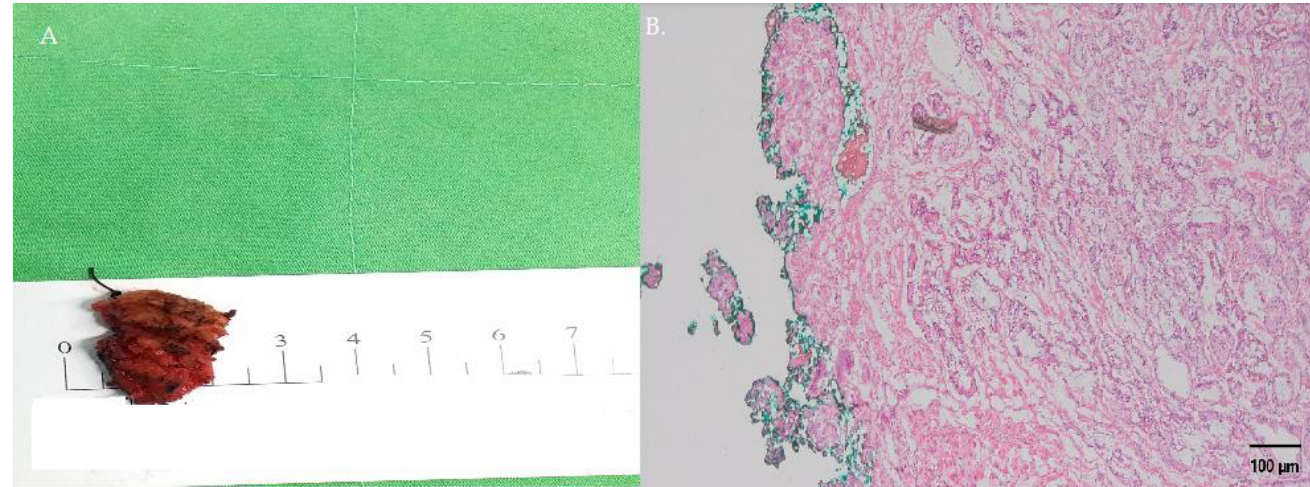
Figure 5. ( A ) The general excised specimen. After precise excision, the frozen specimen was sent to a single pathologist and reviewed immediately. ( B ) The intraoperative frozen review confirmed that there were PCa cells excised with negative surgical margins.